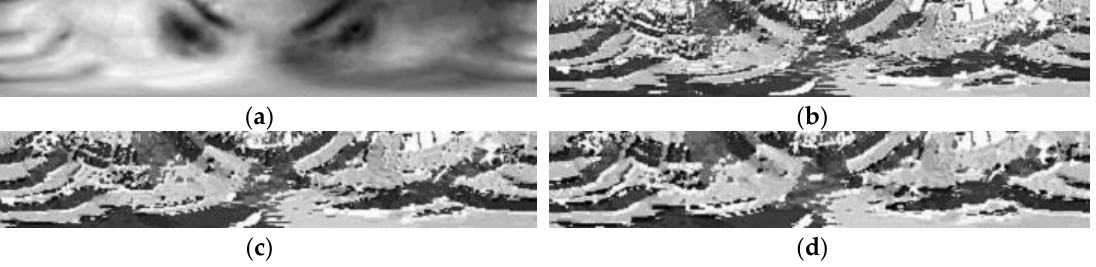
Figure 3. ( a ) Polar image of Cr color channel of Figure 2a; ( b ) Local Binary Patterns (LBP) ( P = 8, R = 1); ( c ) LBP ( P = 8, R = 2), and; ( d ) LBP ( P = 8, R = 3).